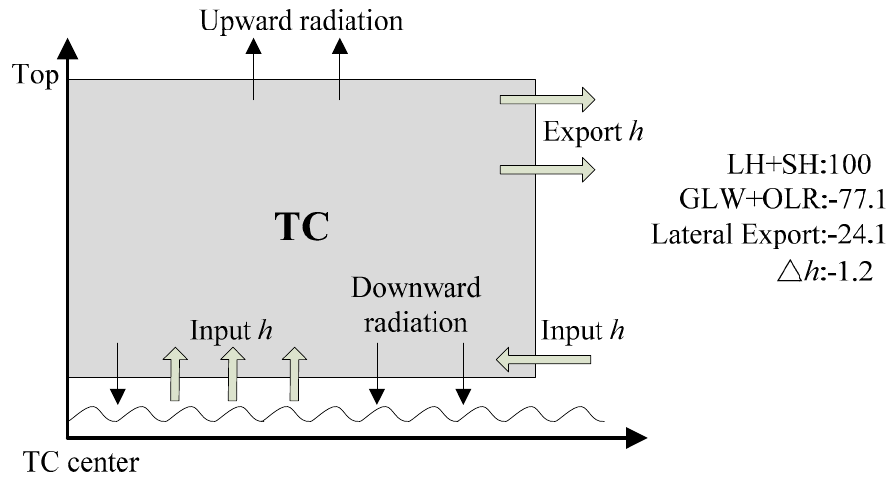
Figure 12. Schematic diagram of in and out of MSE over the tropical cyclone (TC) region. Values shown for terms are averaged after 24 h of integration from volume-integrated, mass-weighted MSE budget and normalized by adjusting the values of surface enthalpy fluxes to 100 W m − 2 .